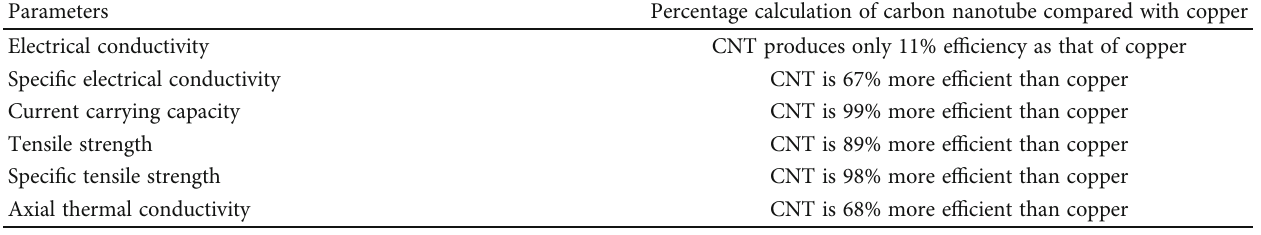
Table 1: Analysis of percentage of carbon nanotube compared with copper for various parameters.